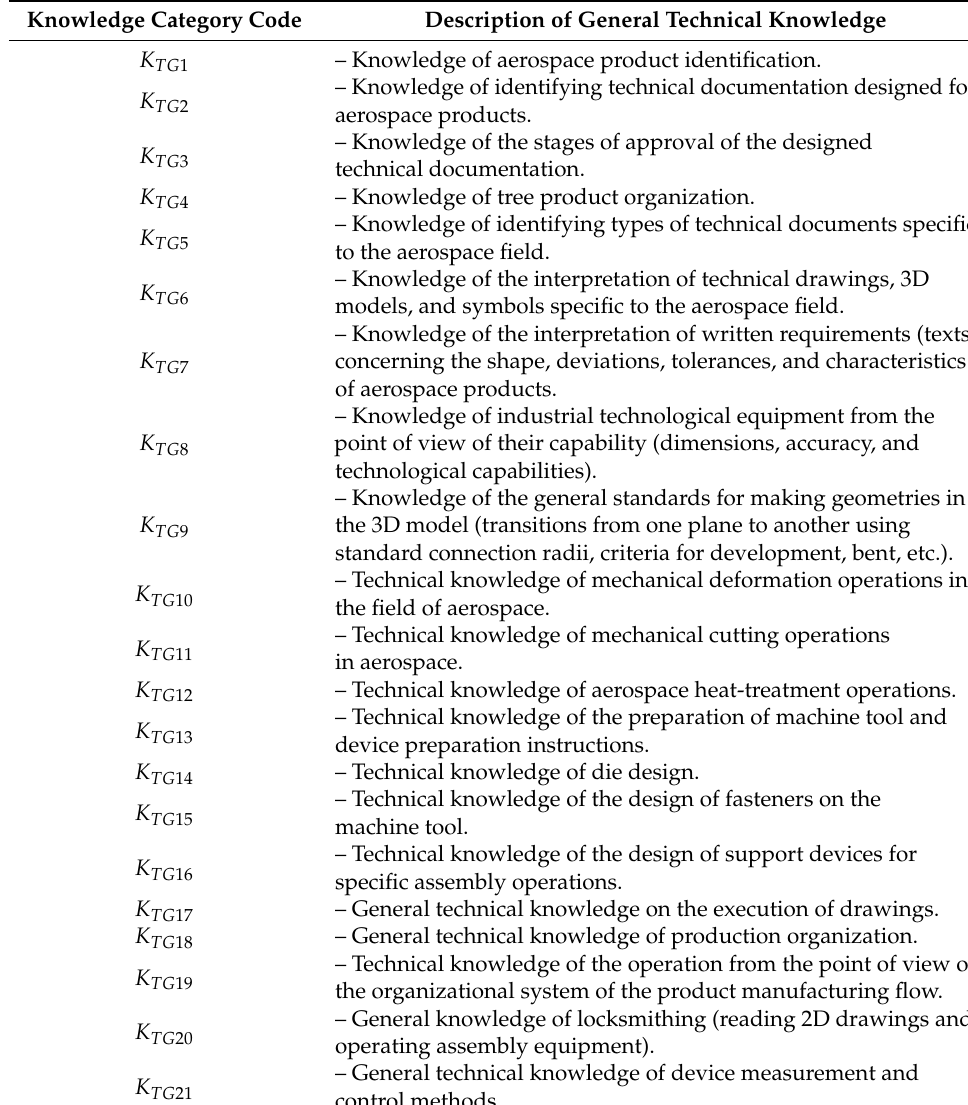
Table 6. List of general technical knowledge required for the global engineering